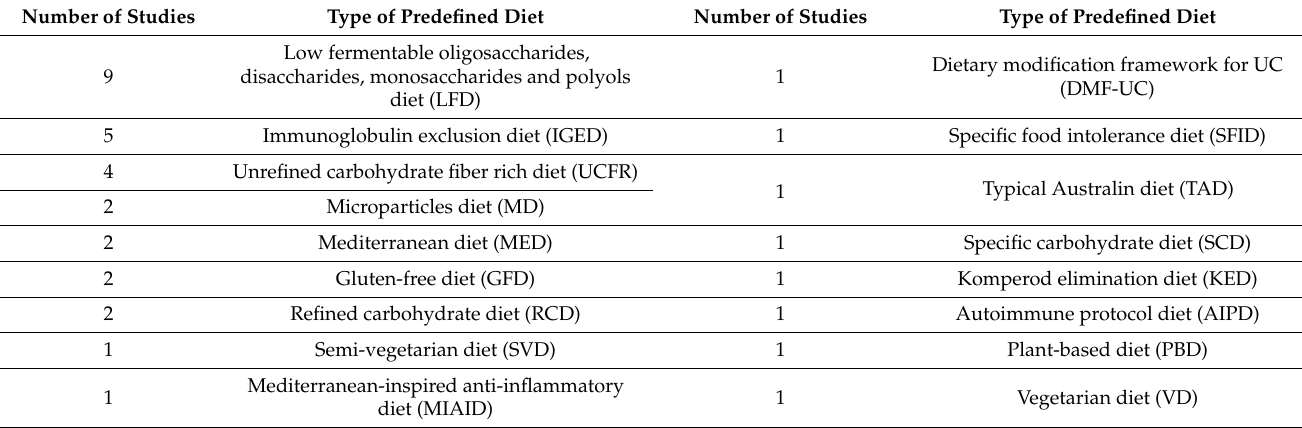
Table 1. Predefined diets in systematic review studies.